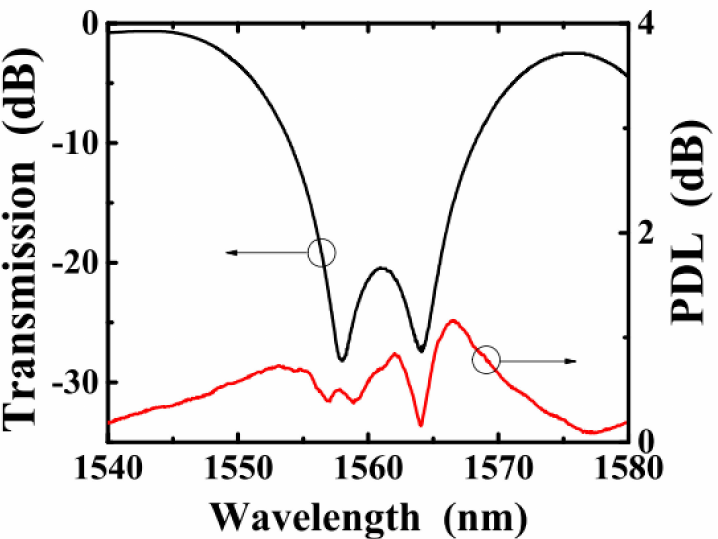
Figure 39. Transmission and PDL spectra of the fabricated phase-modulated HLPG. Adapted with permission from ref. [182]. © [2022]